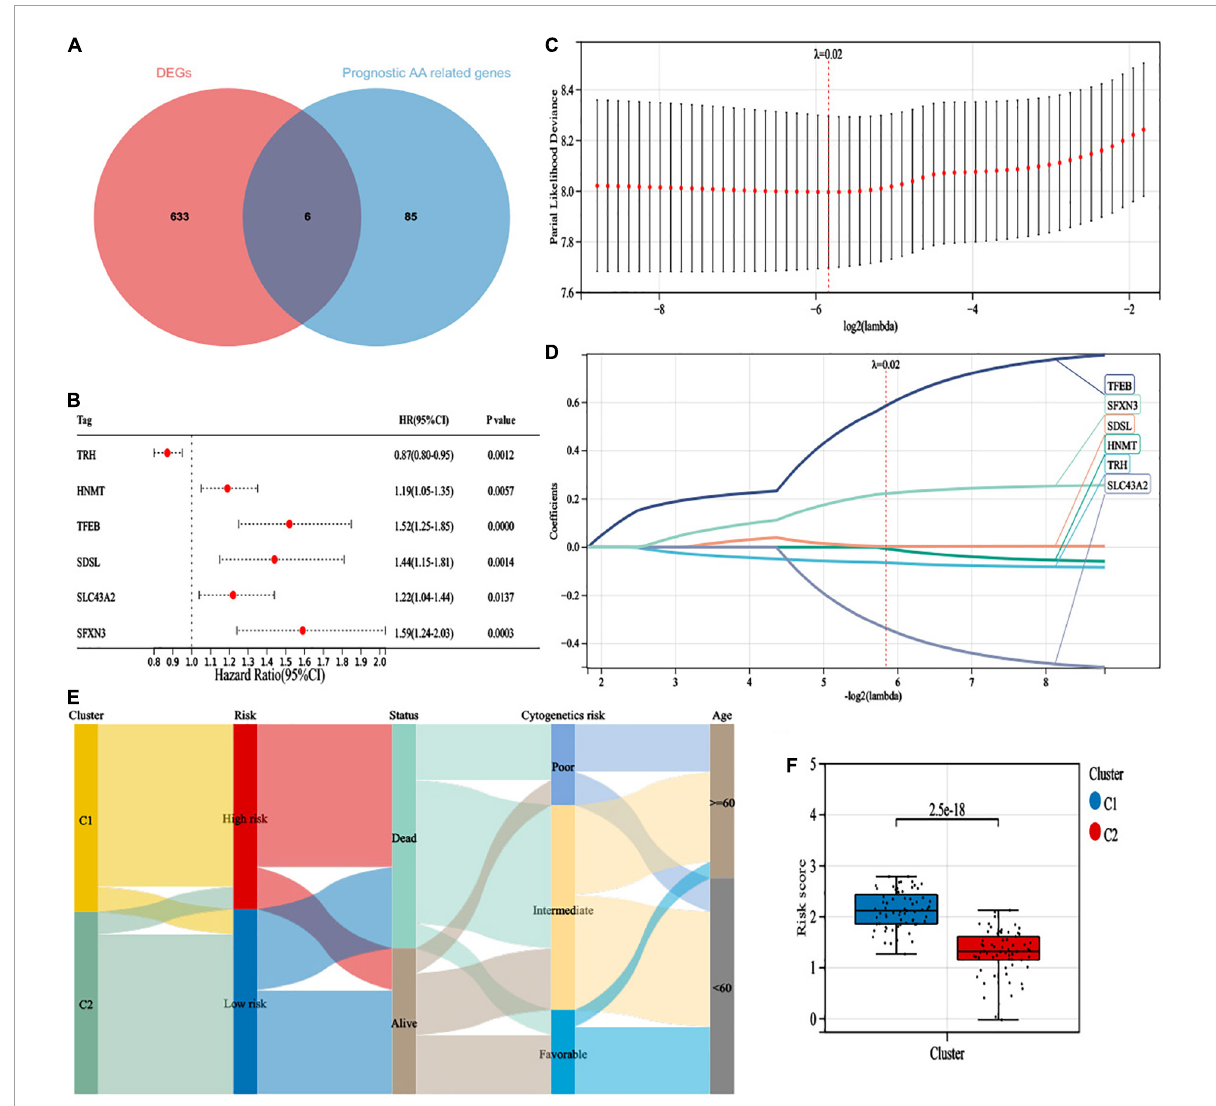
FIGURE3 Construction of a 6-gene risk model. (A) The 6 survival-related amino acid metabolism differentially expressed genes (DEGs) were developed by a Venn diagram. (B) The univariate Cox analysis of OS for 6 survival-related amino acid metabolism DEGs. (C) Least absolute shrinkage and selection operator (LASSO) regression of the 6 survival-related amino acid metabolism DEGs. (D) Cross-validation for all the 6 survival-related amino acid metabolism DEGs. (E) Alluvial diagram of subgroup distributions with different clusters, risk scores, survival status, cytogenetic risk, and age. (F) The distribution of risk scores in different